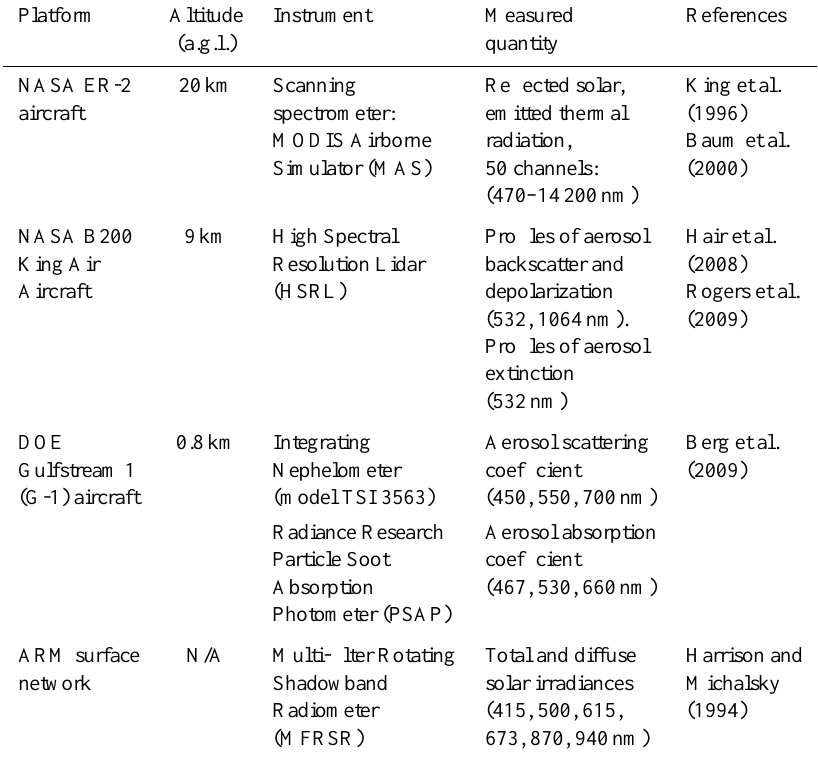
Table 1. List of key instruments used for obtaining optical and radiative properties of aerosol during the case study period.